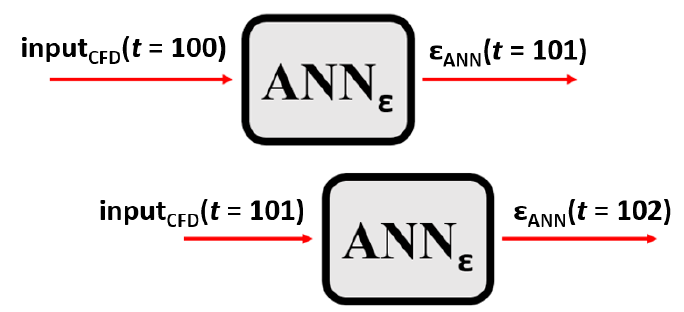
Figure 14. CFD and smart proxy results for gas volume fraction at K = 7 cross-sectional plane (time-step 4004—early time).